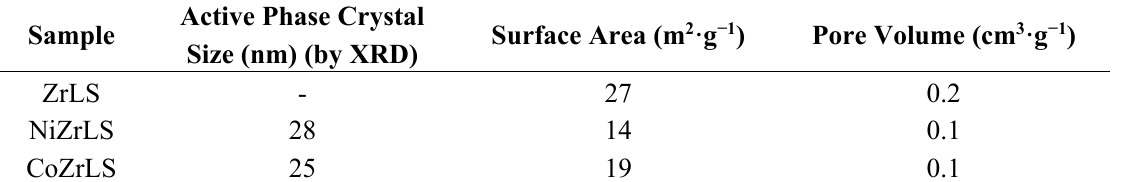
Figure 1. XRD spectra of the impregnated powders. Table 1. Morphological characterization of the